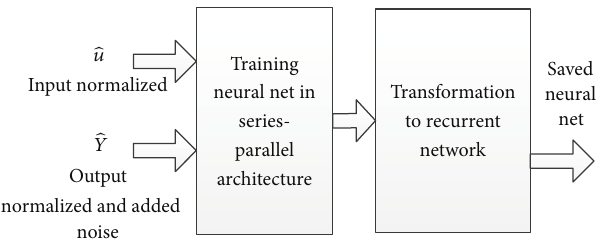
Figure 8: The flow for training the neural